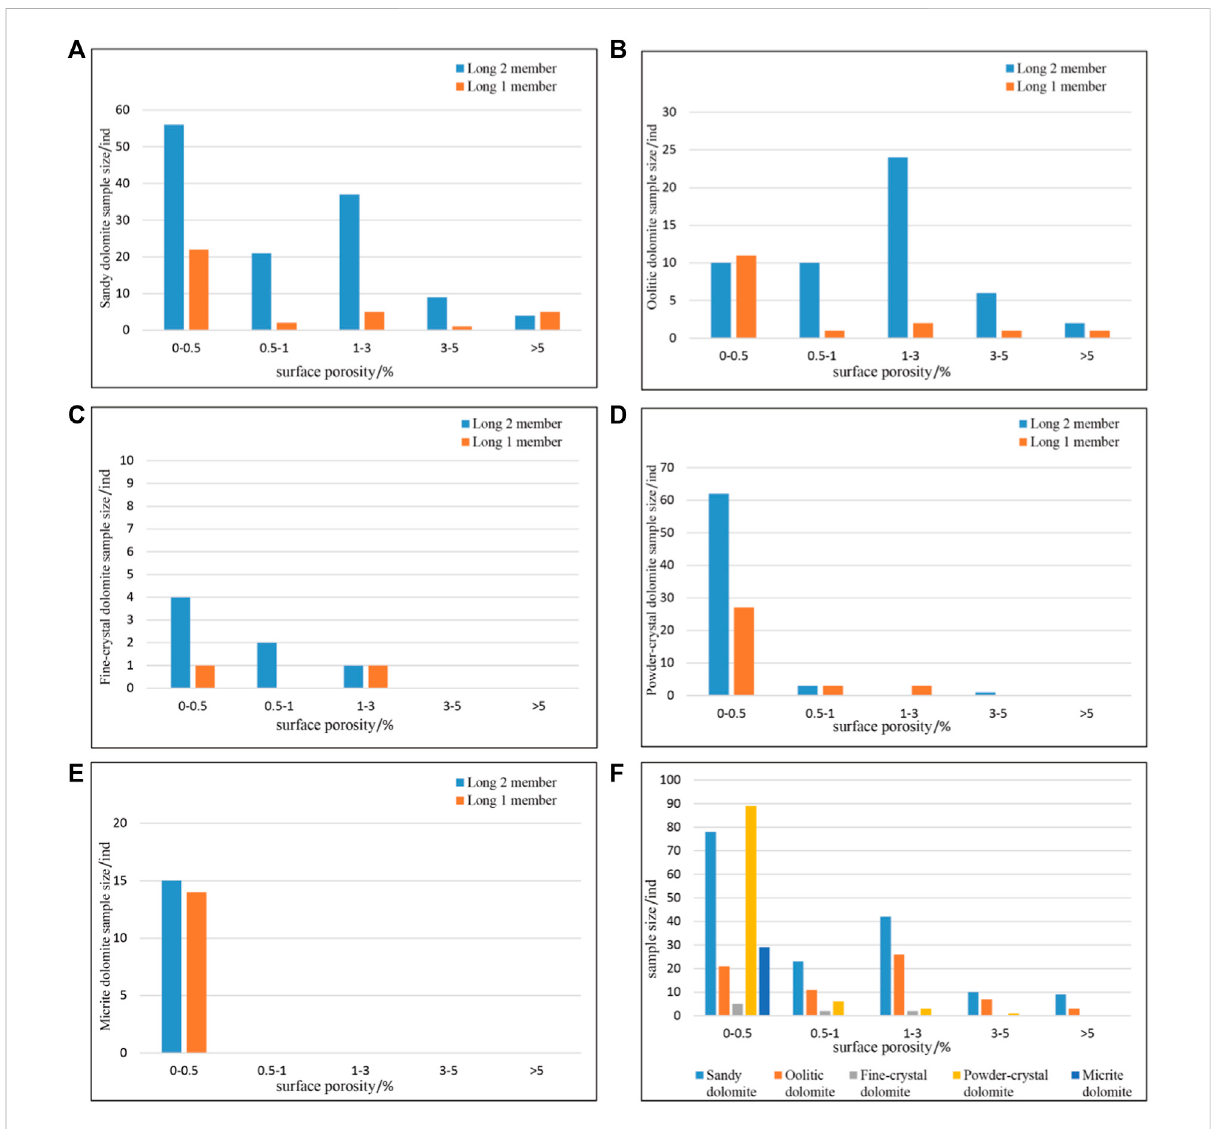
FIGURE 6 Histogram of surface porosity distribution of various lithologies of the Longwangmiao Formation in the study area. (A) Sandy dolomite; (B) Oolitic dolomite; (C) Fine-crystal dolomite; (D) Powder-crystal dolomite; (E) Micrite dolomite; (F) Histogram of surface porosity distribution in the Longwangmiao